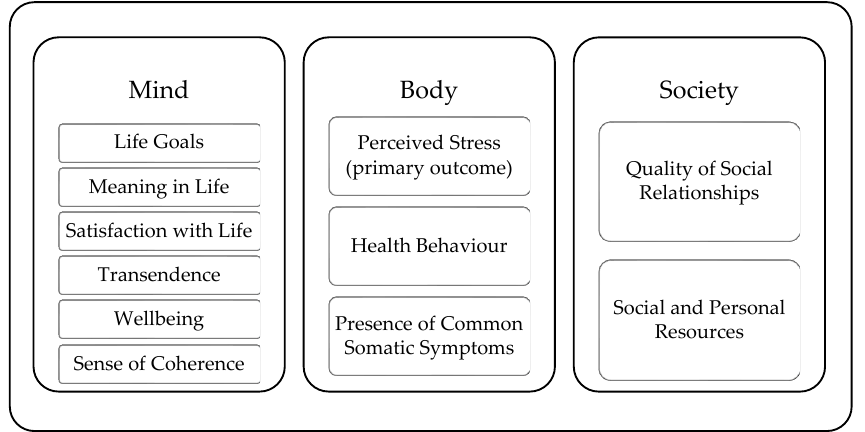
Figure 1. Idea for a holistic understanding of a mind–body–society combination and the underlying concepts we planned to use.